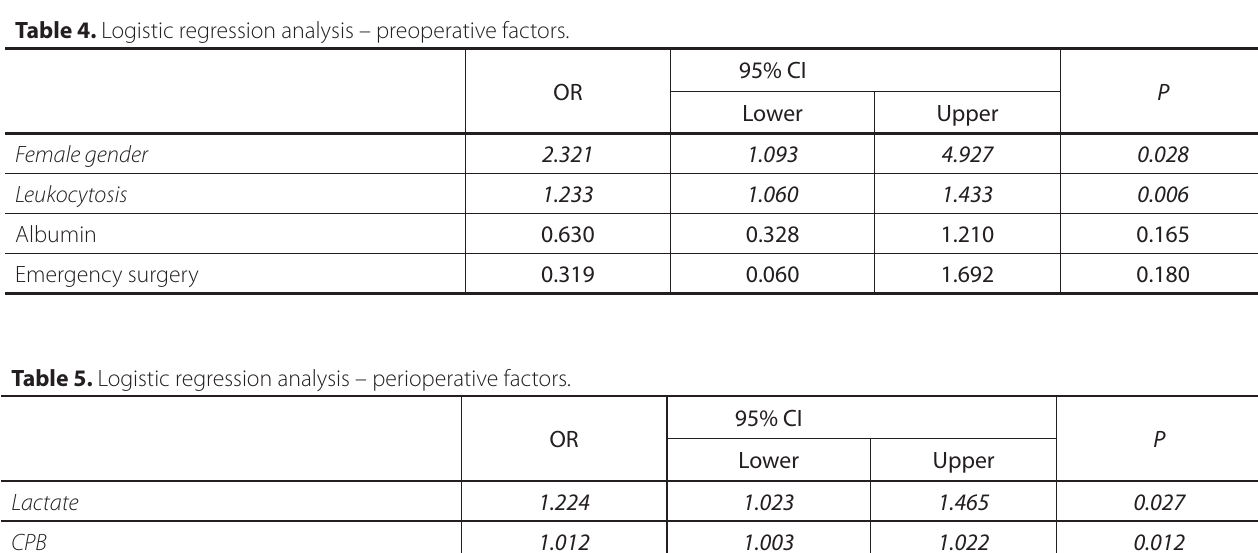
Table 4. Logistic regression analysis – preoperative factors.